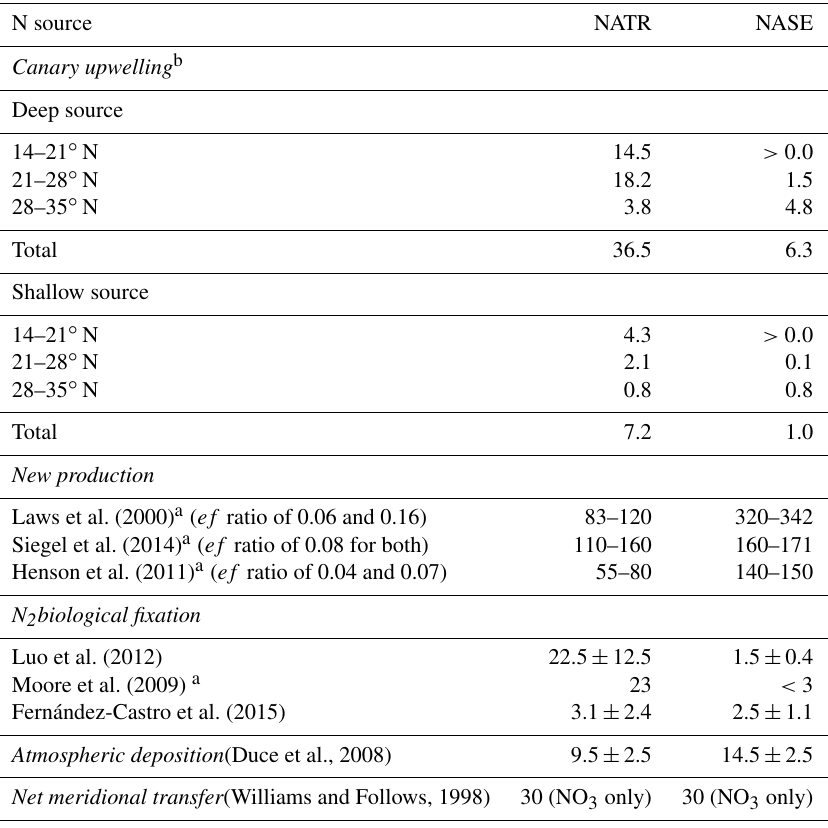
Table 3. Nitrogen sources and sinks for the NATR and NASE provinces (in mmolNm − 2 yr − 1 ). Sources considered are the offshore transport by the Canary upwelling, the net meridional transfer of nitrogen through Ekman divergence, N 2 fixation and atmospheric deposition. The only sink considered is new production